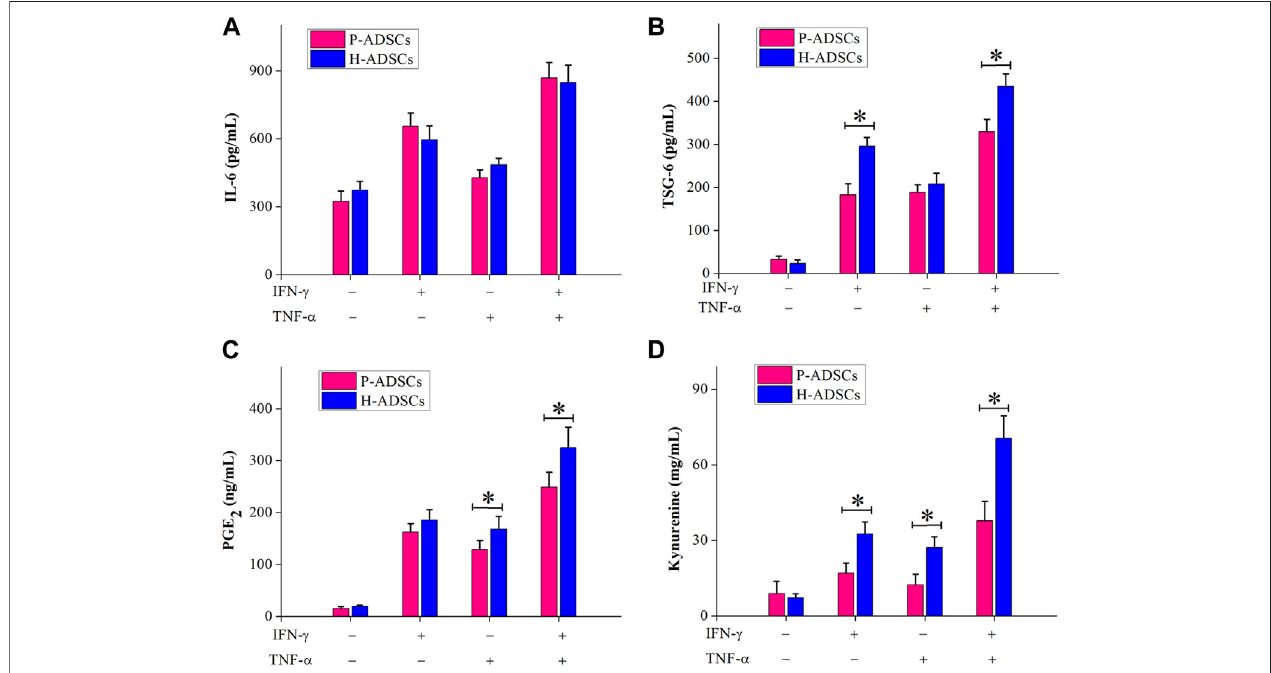
FIGURE 5 | Immunosuppressive mediators involved in the immunosuppressive effect of P-ADSCs and H-ADSCs. P-ADSCs or H-ADSCs were primed with IFN- γ and TNF- α separately or combined for 48 h. Levels of the immunosuppressive factors IL-6 (A) , TSG-6 (B) , and PGE 2 (C) determined by ELISA. (D) IDO activity expressed as the concentration of kynurenine ( n = 7; * p < .05 determined by the Wilcoxon-Mann-Whitney nonparametric